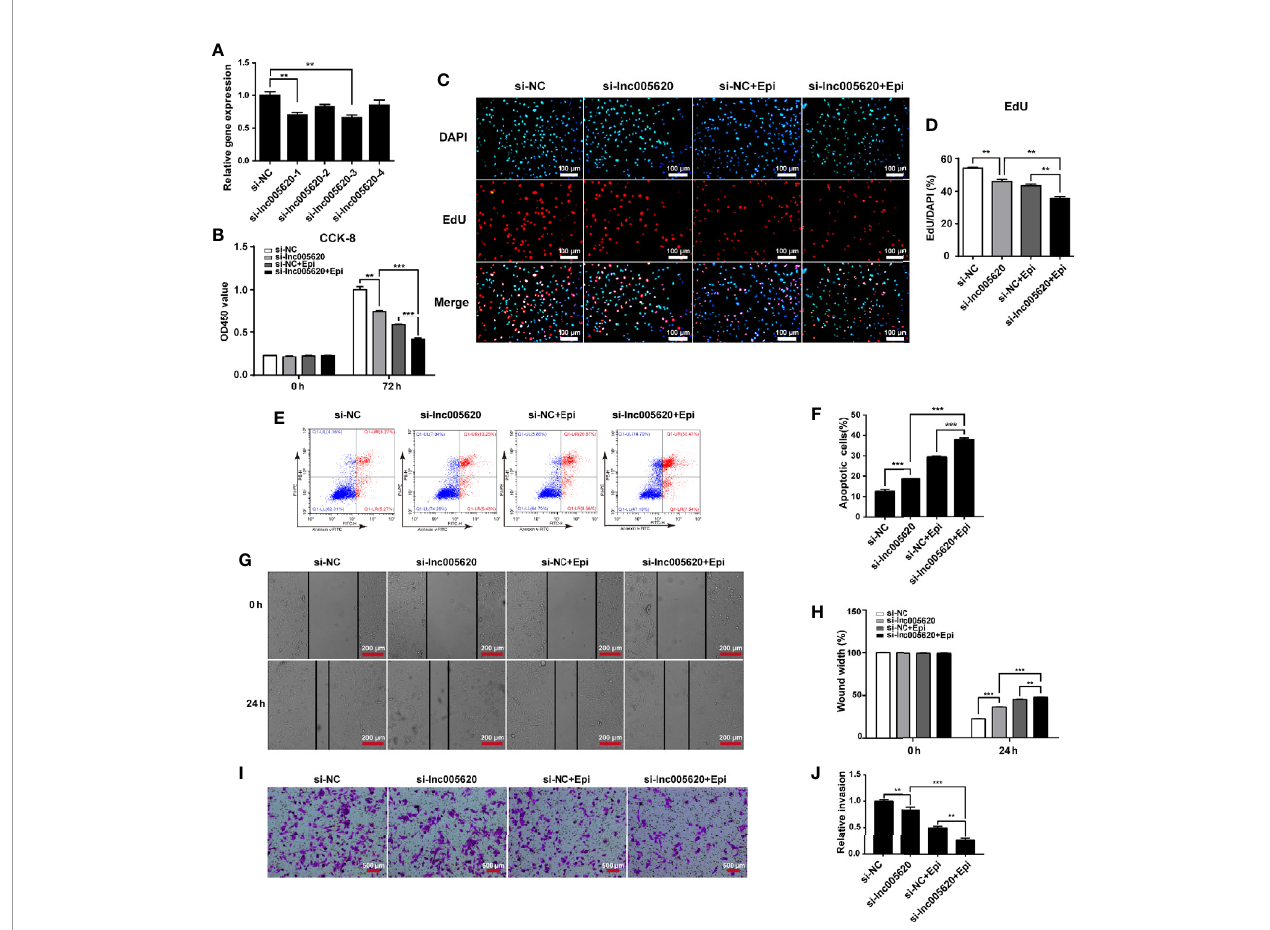
FIGURE 4 | Inhibition of lnc005620 alleviates proliferation, invasion and epirubicin resistance in MDA-MB-231 cells. lnc005620 was knocked down in epirubicin- resistant MDA-MB-231 cells treated with or without 12.5 ng/ml epirubicin. (A) RT-qPCR validation of lnc005620 expression. (B) Cell proliferation analysis by CCK-8 assay. (C) Cell proliferation analysis by EdU assay. DAPI for nuclei. Scale bars: 100 m m. (D) Quantitative analysis of EdU assay. (E) Flow cytometry analysis of cell apoptosis. (F) Quantitative analysis of apoptotic cell percentages. (G) Cell migration analysis by wound healing assay. Scale bars: 200 m m. (H) Quantitative analysis of cell migration. (I) Cell invasion analysis by Transwell assay. Scale bars: 500 m m. (J) Quantitative analysis of cell invasion. si-NC, negative control; si-lnc005620, siRNA against lnc005620; si-NC+Epi, negative control and exposure to epirubicin; si-lnc005620+Epi, siRNA against lnc005620 and exposure to epirubicin. n = 3. Data are represented as the mean ± SD, ** P < 0.01, *** P <